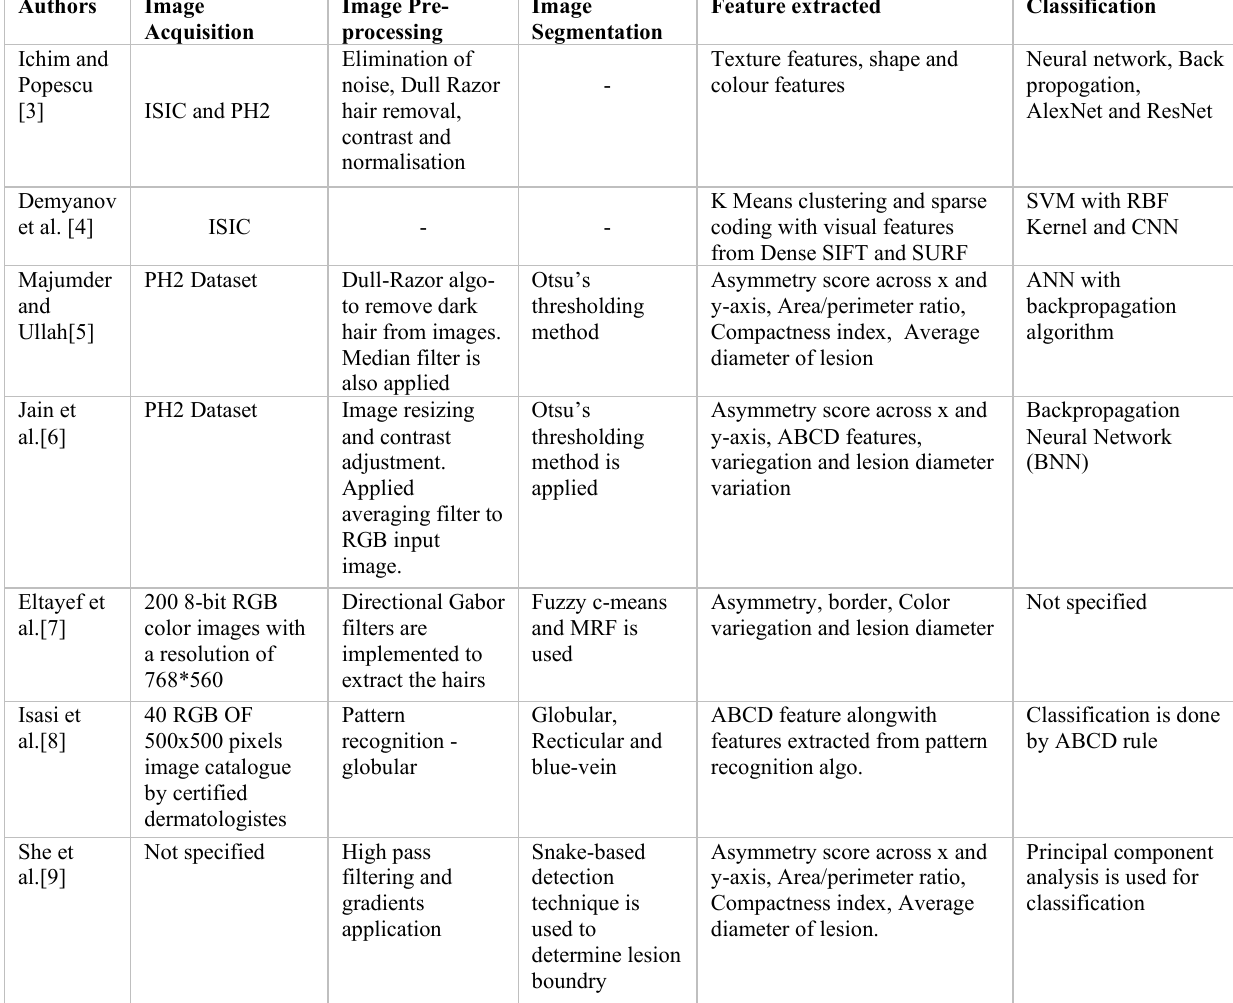
Table 2.1: Survey of Existing